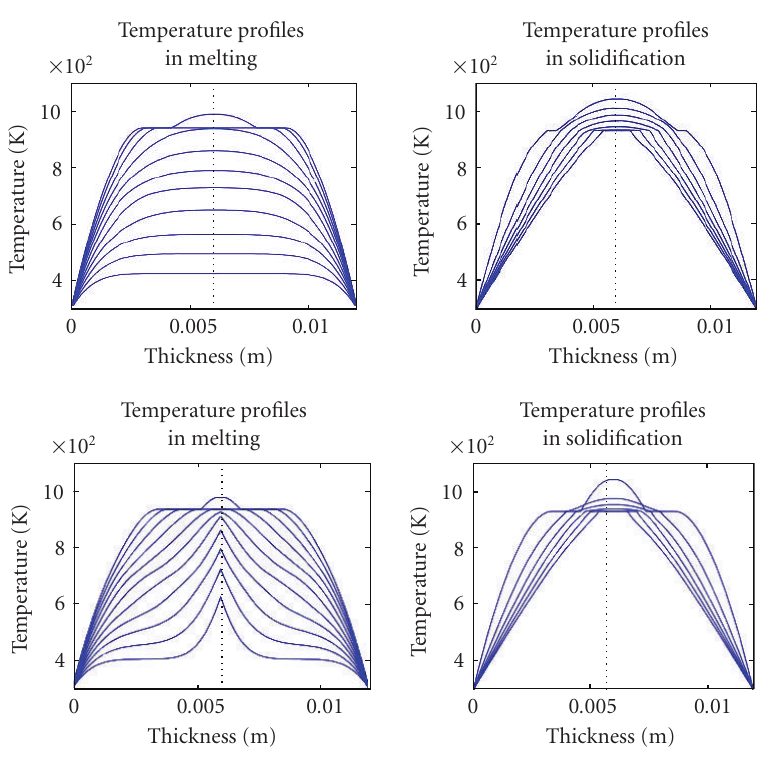
Figure 4.3. Example 1: spatial and temporal variation of temperature: R g = 0 (top), R g = 10 − 9 initially (bottom). The curves represent equal time